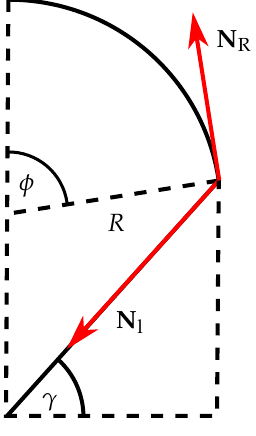
Figure 9. Forces acting at the connection of the top layer and cross threads. The vector N l denotes the membrane force acting in the cross threads, and N R is a hoop force acting in the top layer. Both are defined as forces per unit length. The magnitudes N l and N R can be calculated from the balance of vertical force components, as shown